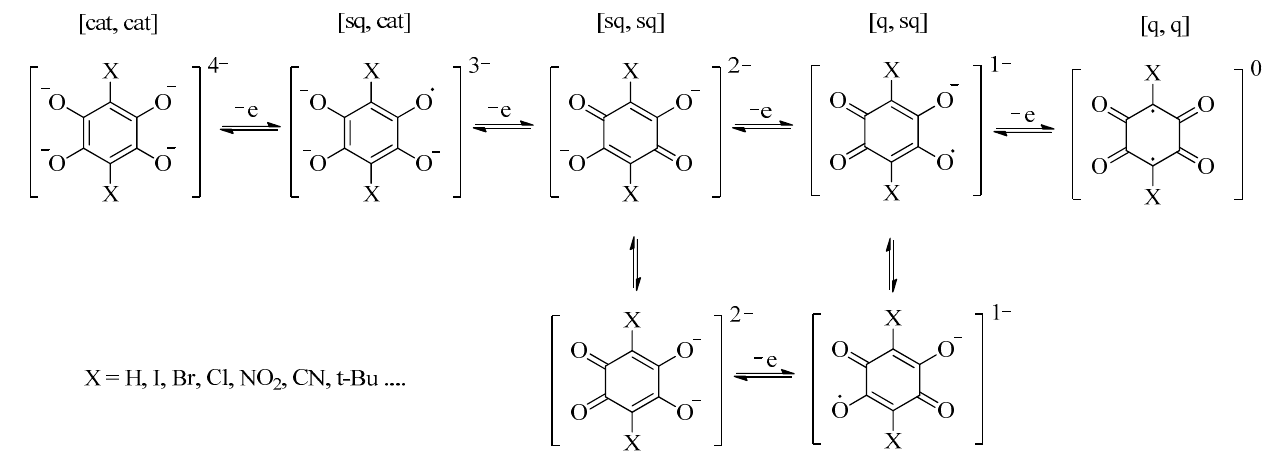
Figure 1. Redox states of anilate-type ligands.